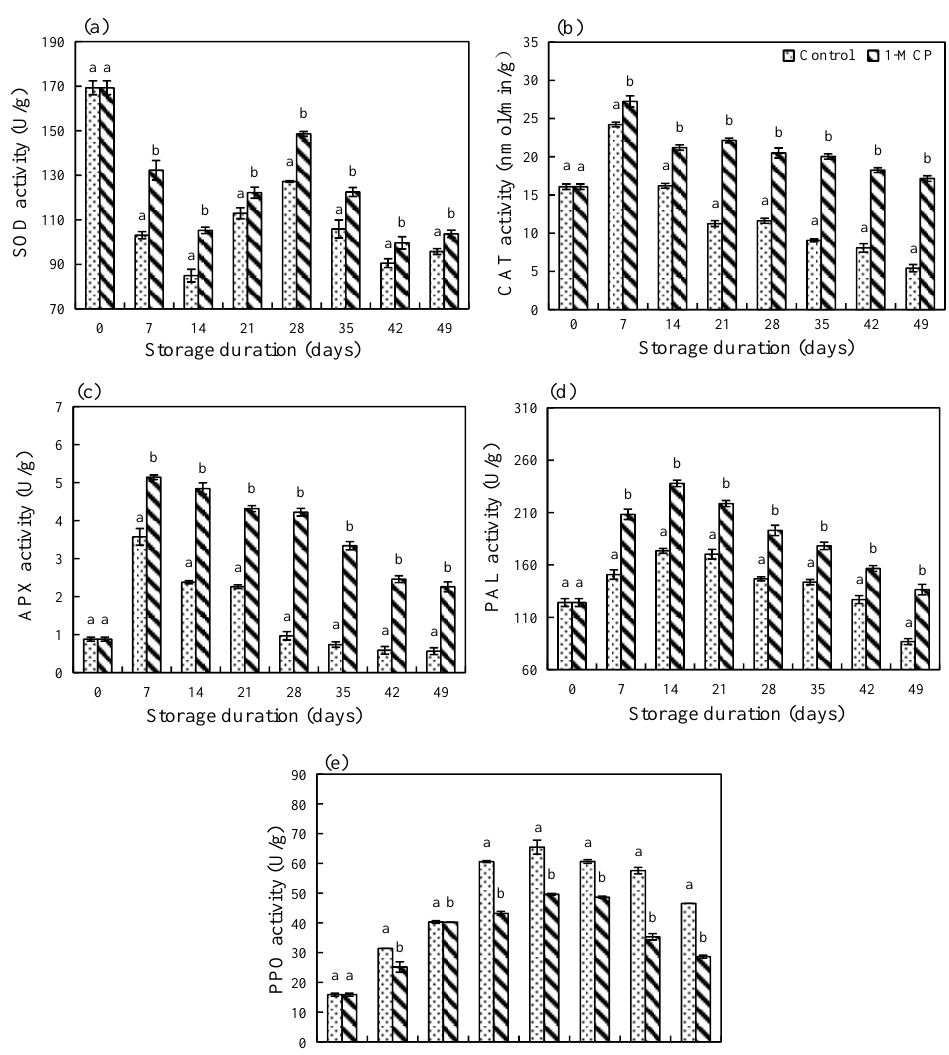
Figure 8. Effects of 1 − MCP treatment on antioxidant enzyme activity of “Dianhong” rose petals in different storage periods: ( a ) Effects of 1 − MCP on SOD enzyme activity; ( b ) Effects of 1 − MCP on CAT enzyme activity; ( c ) Effects of 1 − MCP on APX enzyme activity; ( d ) Effects of 1 − MCP on PAL enzyme activity; ( e ) Effects of 1 − MCP on PPO enzyme activity; Different letters on the bar chart indicate significant differences among group ( p < 0.05, n = 3).